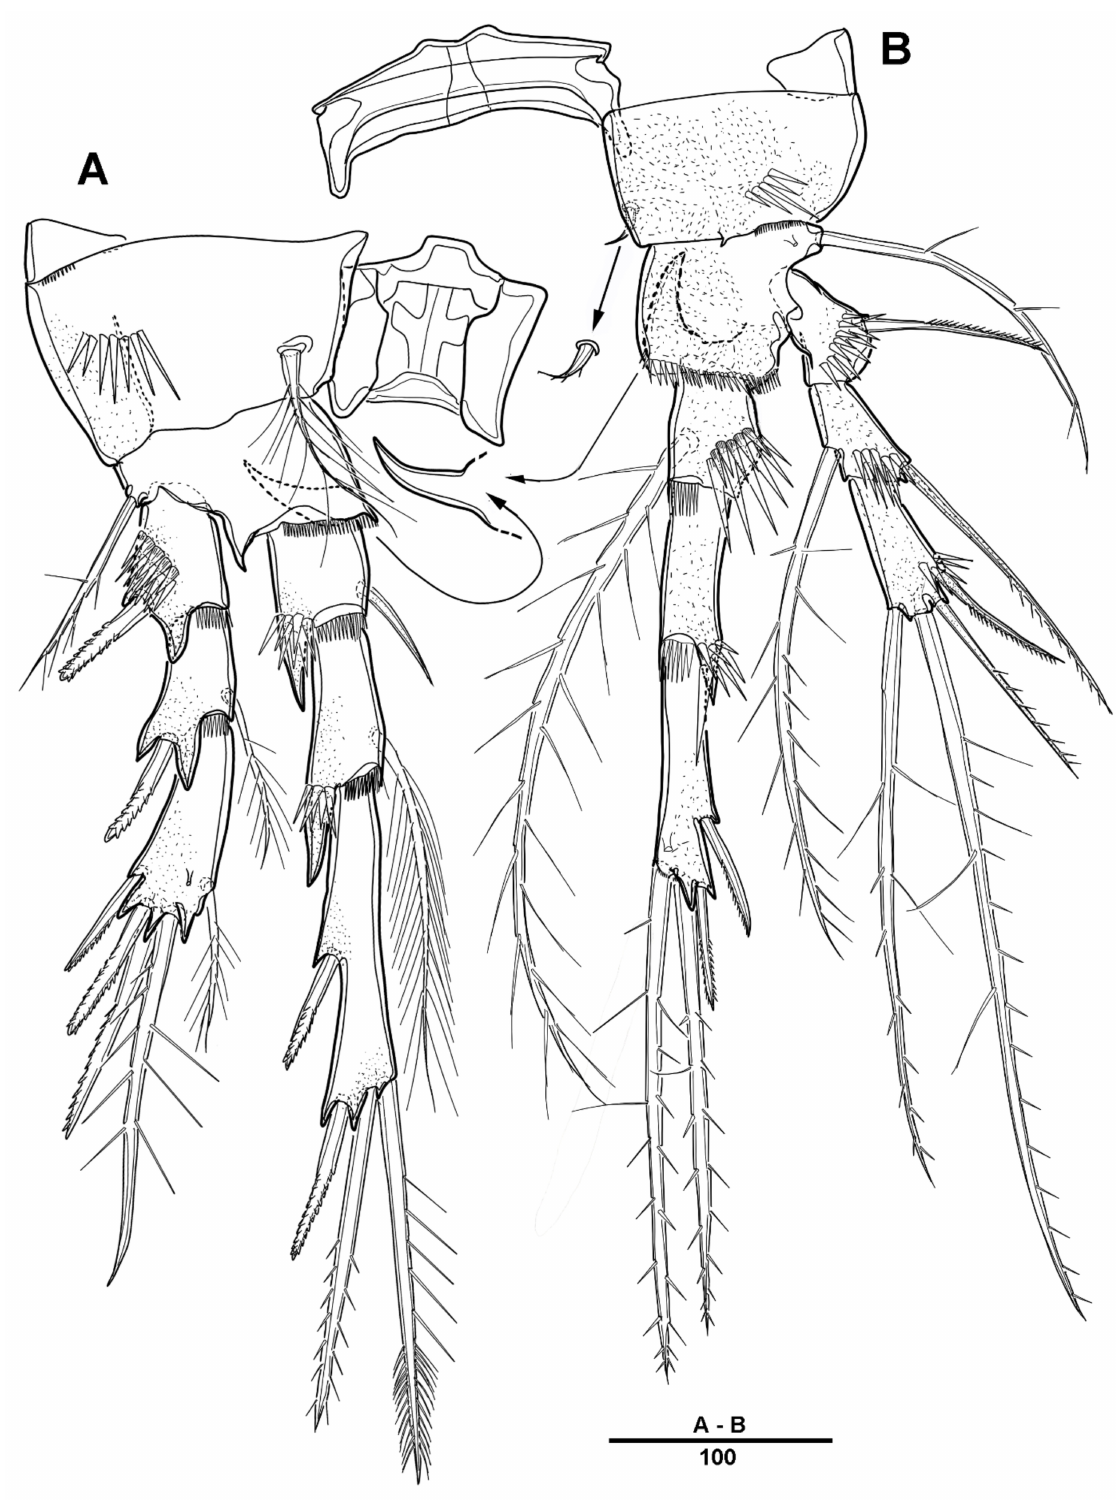
Figure 18. Scottolana wonchoeli sp. nov. holotype female: ( A ) P3, anterior; ( B ) P4, anterior. Scale bars in µ